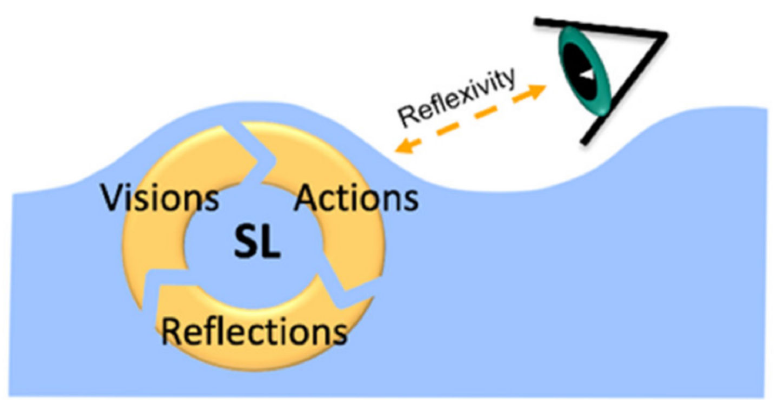
Figure 3. Embedding reflections and reflexivity in the SL process. Source: Modified illustration based on Nolbrant [49]. Published with permission by